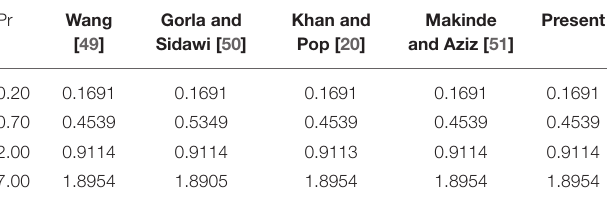
TABLE 4 | Matching results of reduced Nusselt number with the restricting case